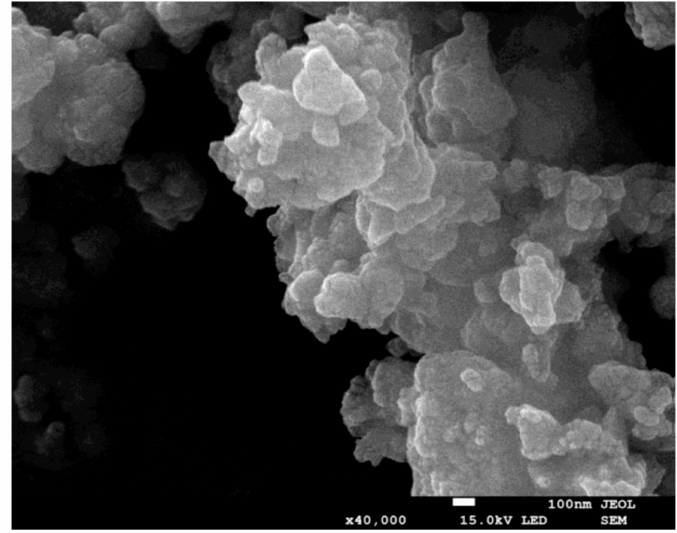
Figure 3. SEM image of the 100 h milled powder after